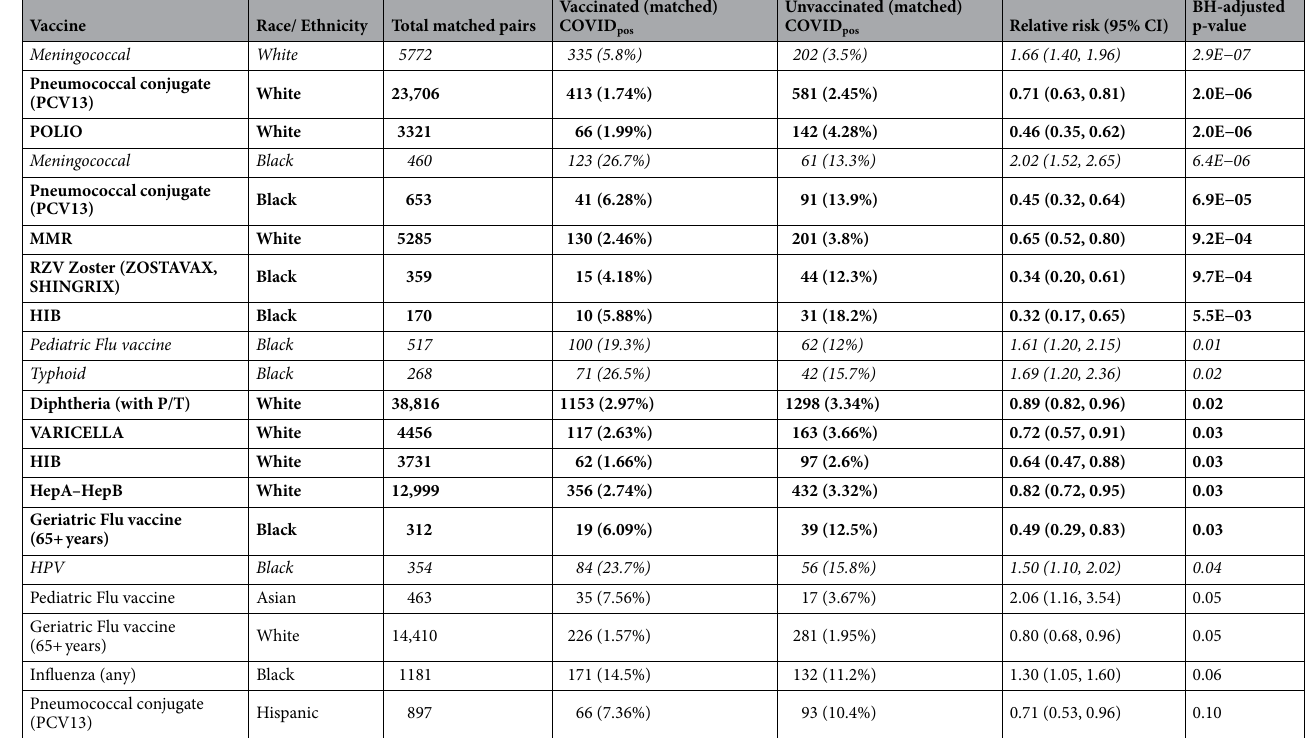
Table 9. Summary of SARS-CoV-2 rates for race/ethnicity-stratified vaccinated and unvaccinated propensity score matched cohorts (5 year time horizon). Table of SARS-CoV-2 infection rates for vaccinated and unvaccinated (matched) race/ethnicity subgroup cohorts for vaccines administered within 5 years prior to PCR testing. Only rows with adjusted p-values ≤ 0.1 are included. Rows in which the SARS-CoV-2 rate is lower (adjusted p-value < 0.05) in the vaccinated cohort are highlighted in bold, and rows in which the SARS- CoV-2 rate is lower in the unvaccinated cohort are highlighted in italics. The columns are (1) Vaccine: Name of the vaccine, (2) Race/ethnicity: Race/ethnicity subgroup, (3) Total matched pairs: Number of pairs from the propensity matching procedure, which is the sample size of both vaccinated and unvaccinated cohorts after matching, (4) Vaccinated (matched) COVID pos : Number of COVID pos cases among the vaccinated (matched) cohort, along with the percentage in parentheses, (5) Unvaccinated (matched) COVID pos : Number of COVID pos cases among the unvaccinated (matched) cohort, along with the percentage in parentheses, (6) Relative risk (95% CI): Relative risk of COVID pos in the vaccinated (matched) cohort compared to